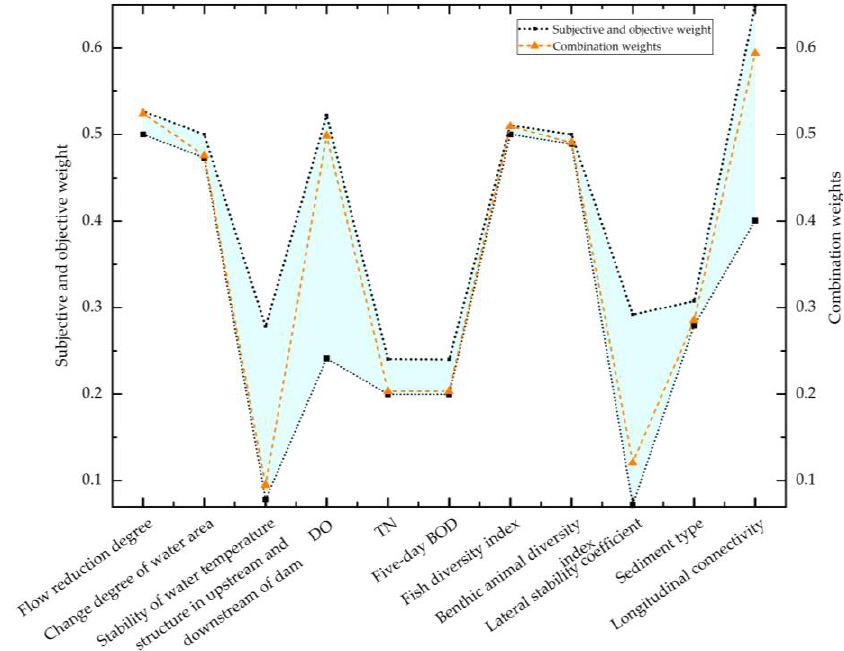
Figure 2. Weight calculation results of Tufang River assessment index (2018).